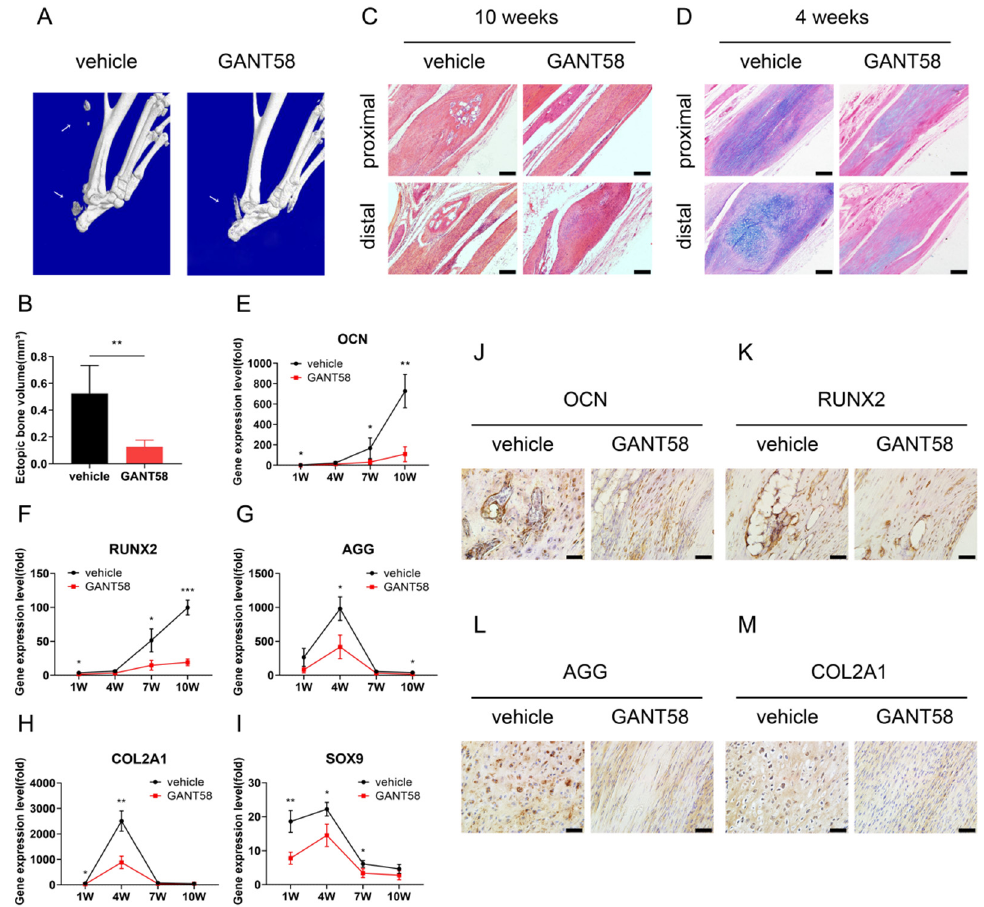
Figure 3. Inhibition of Hedgehog signalling suppresses formation of endochondral ossification in injured tendons. ( A ) Micro-CT images of the vehicle and GANT58 groups 10 weeks postinjury. ( B ) Quantification of the volume of ectopic mineralized bone. ( C ) H&E staining of the vehicle and GANT58 groups 10 weeks postinjury. Scale bar = 100 µ m. ( D ) Alcian blue staining of the vehicle and GANT58 groups 4 weeks postinjury. Scale bar = 100 µ m. ( E – I ) qRT–PCR analysis of osteogenic- specific genes such as OCN ( E ) and RUNX2 ( F ) and chondrogenic-specific genes such as AGG ( G ), COL2A1 ( H ), and SOX9 ( I ) in tendon specimens of the vehicle and GANT58 groups 1, 4, 7, and 10 weeks postinjury. ( J , K ) Images of IHC staining of OCN ( J ) and RUNX2 ( K ) in the tendons of the vehicle and GANT58 groups 10 weeks postinjury. Scale bar = 20 µ m. ( L , M ) Images of IHC staining of AGG ( L ) and COL2A1 ( M ) in the tendons of the vehicle and GANT58 groups 4 weeks postinjury. Scale bar = 20 μ m. * p < 0.05, ** p < 0.01, *** p < 0.001.